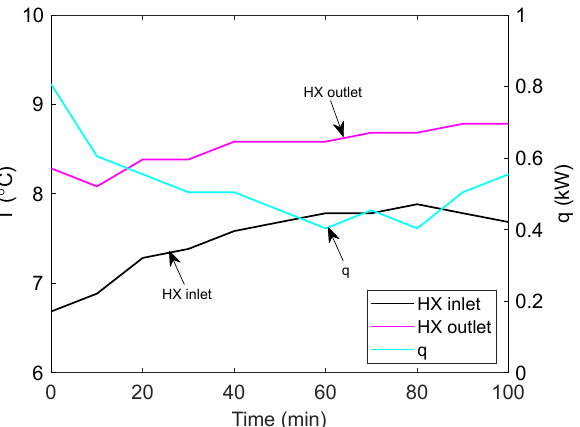
Figure 7. Heat exchanger inlet and outlet temperatures, and the corresponding instantaneous heat transfer rates for Test Condition 3.